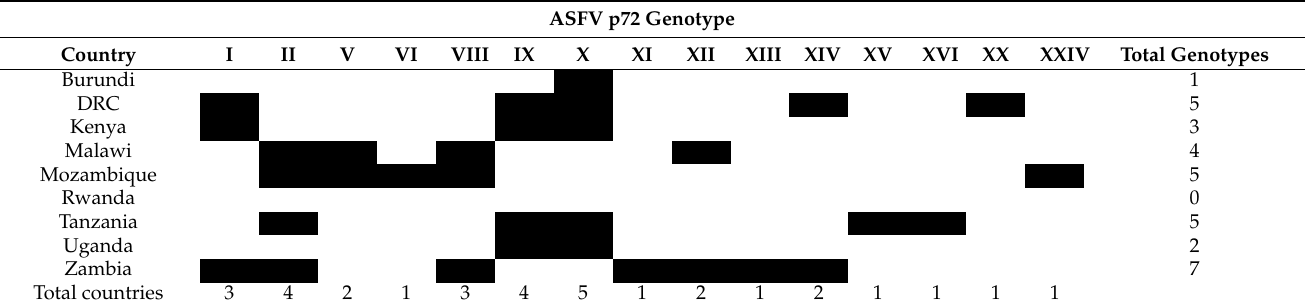
Table 2. Summary of the ASFV p72 genotypes distribution in Tanzania and neighboring countries. The black highlight indicates that the corresponding genotype is